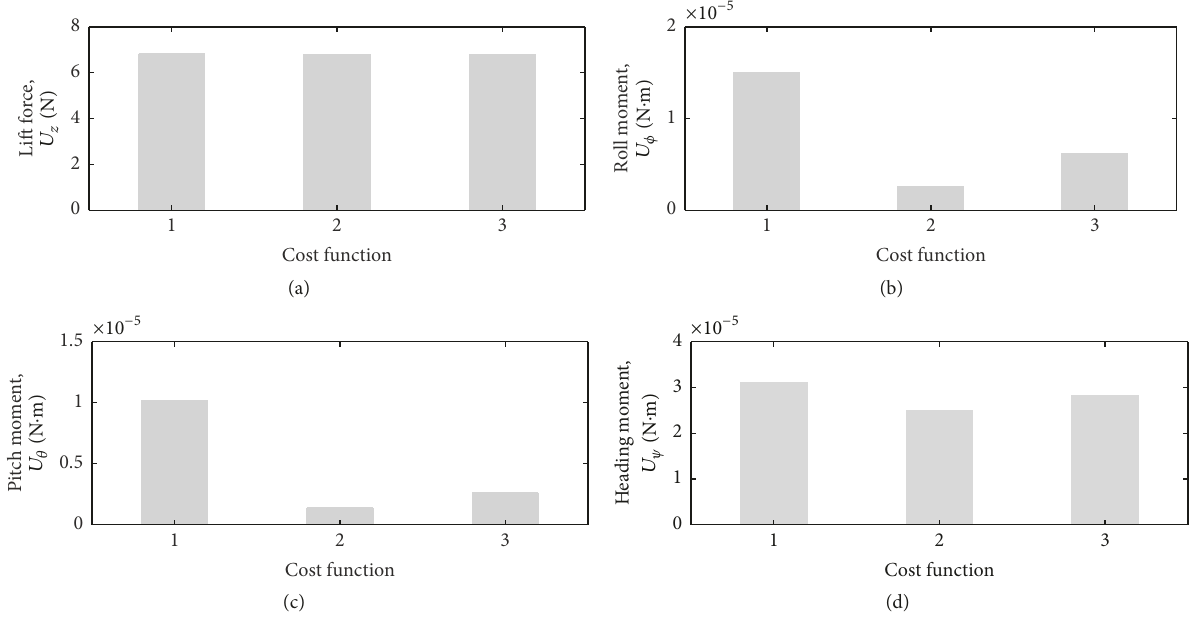
Figure 11: Mean values of (a) lift force and aerodynamical (b) roll and (c) pitch and (d) heading moments,